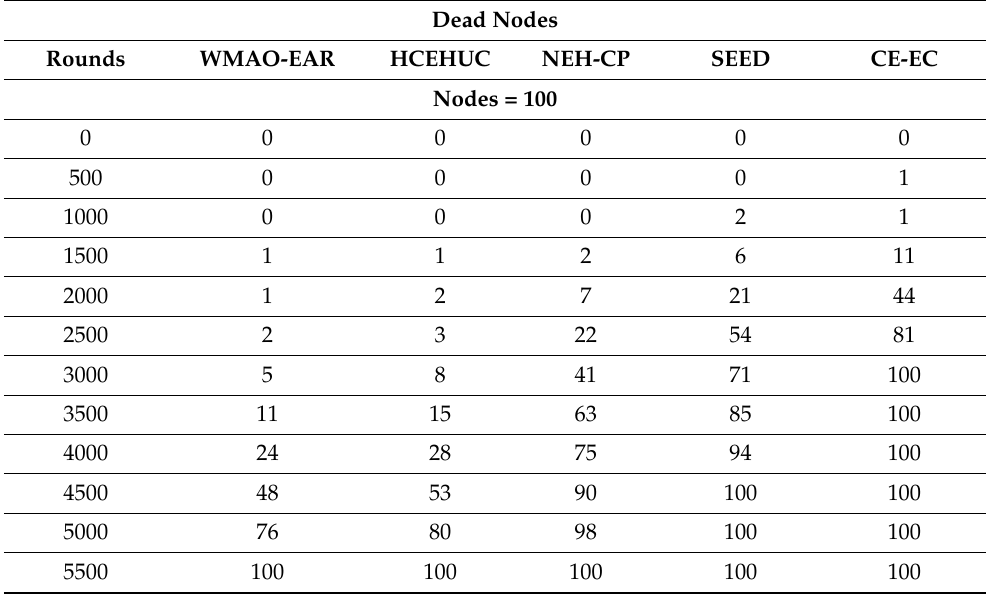
Table 4. NODN analysis of WMAO-EAR approach with existing algorithms under NC of 100 and